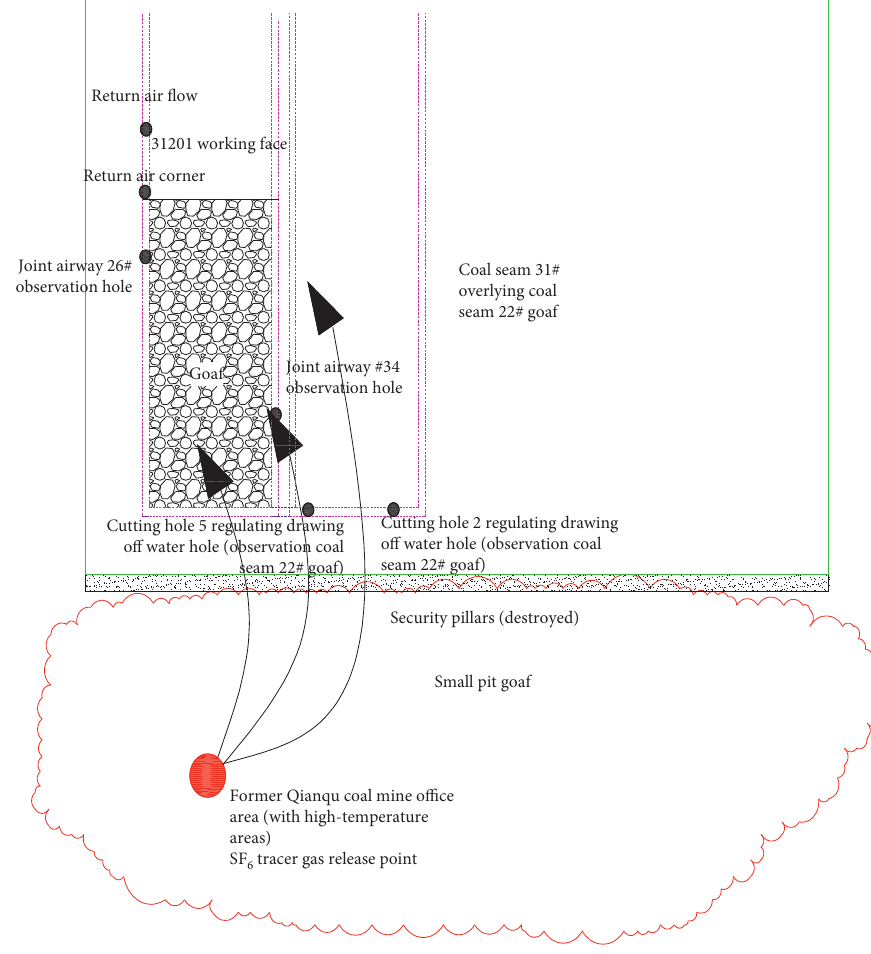
Figure 8: Detection of air-leaking